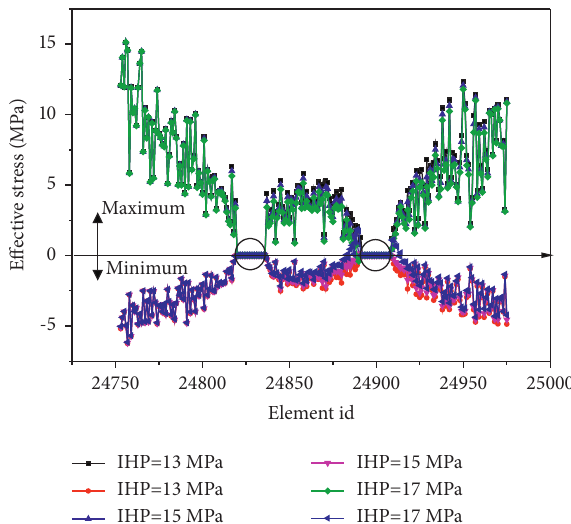
Figure 13: Effective minimum principal stress distributions along the wellbore center.